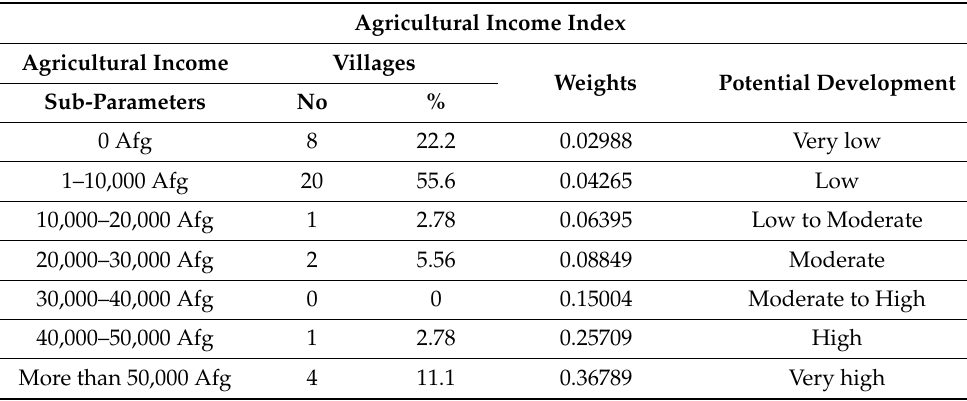
Figure 10. The histogram for the “Agricultural income” index. Table 11. Classification of the “Agricultural income” index with their weights.